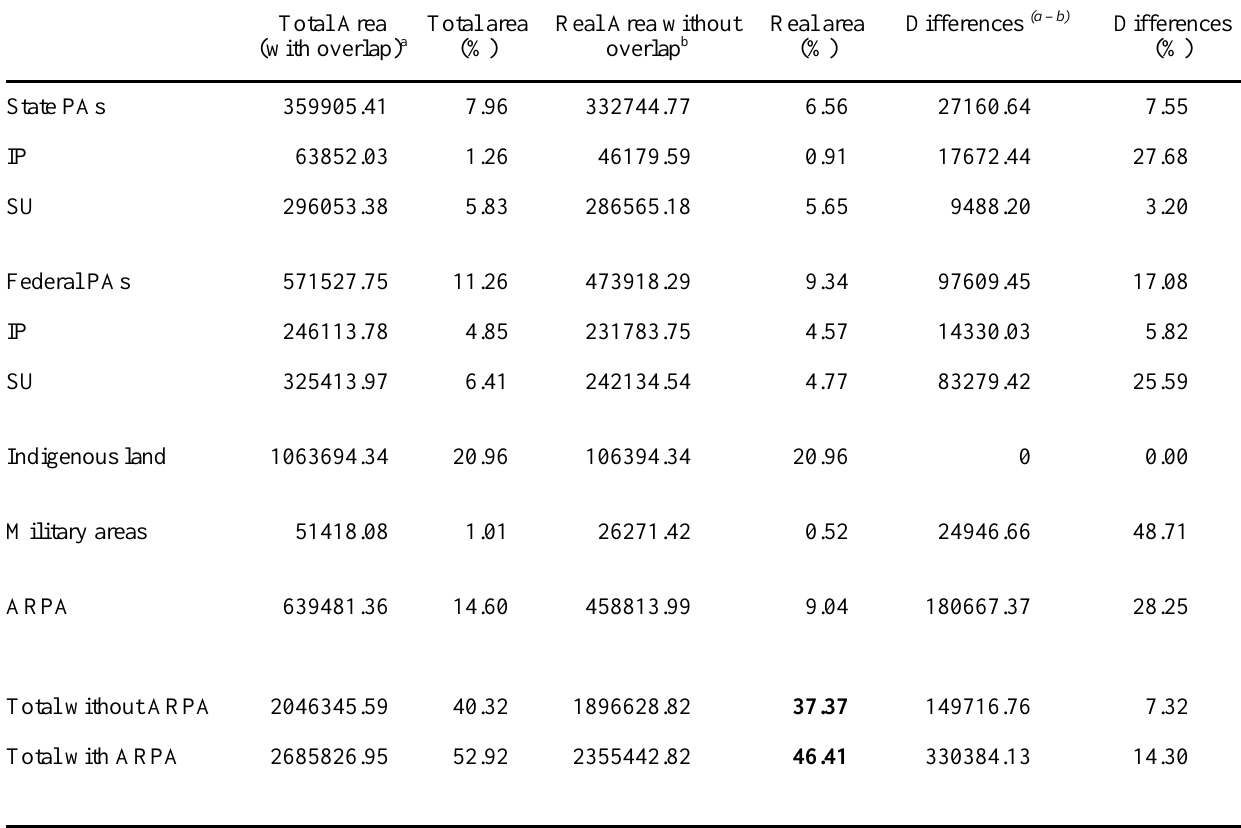
Table 1. Size (km 2 ) of protected areas (PAs) in the Brazilian Amazon with and without overlap with other units. PI = integral protection; US = sustainable